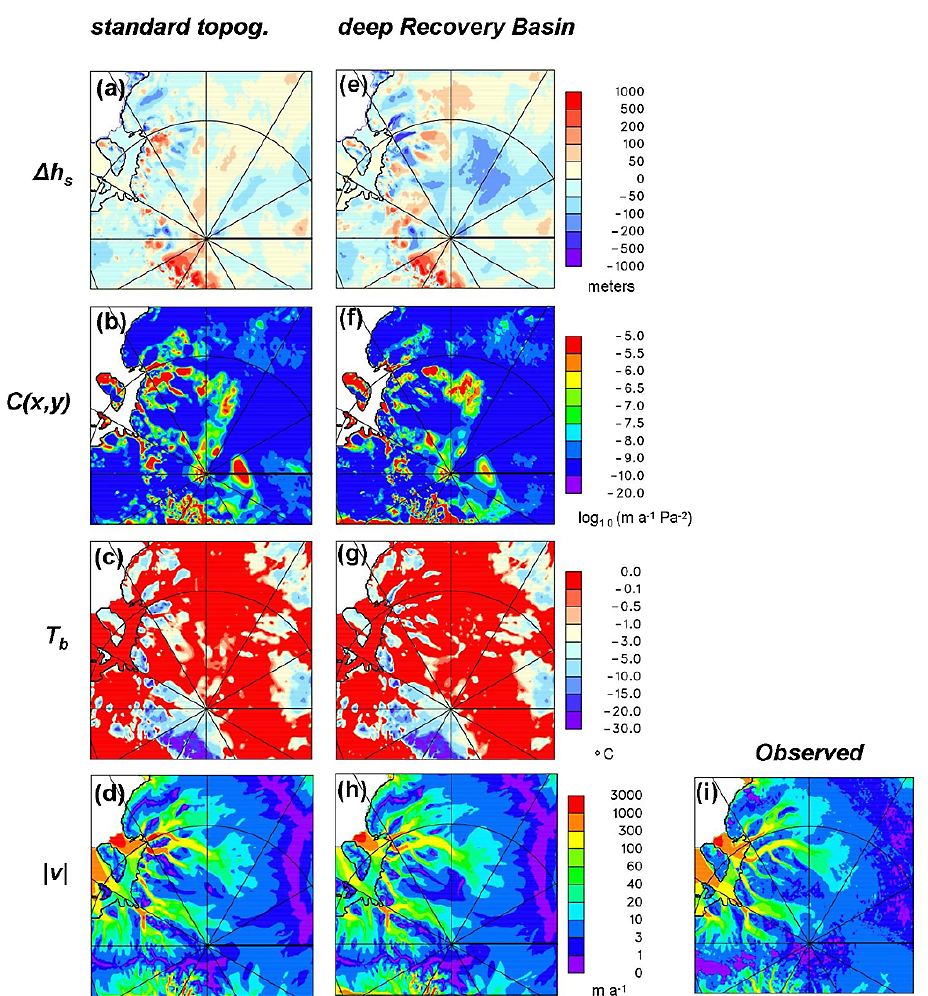
Fig. G2. Results with standard (left) vs. deeper (right) bed topography in the Recovery Glacier basin. Top row: model minus observed surface ice elevation, meters. Second row: basal sliding coefficients C(x,y) , log 10 (ma − 1 Pa − 2 ) . Third row: homologous basal temperatures T b , ◦ C. Bottom row: surface ice velocity, ma − 1 . Left column (a–d) : using inverse method with sub-grid topographic influence, limited-domain nested run at 10-km resolution with lateral boundary conditions from corresponding continental run. Middle column (e–h) : as (a–d) , except using alternate bed topography with deeper elevations in Recovery Glacier drainage basin (Le Brocq et al., 2008). Right column (i) : observed surface ice velocity (Rignot et al., 2011), averaged here to 10-km model cells, ma − 1 .